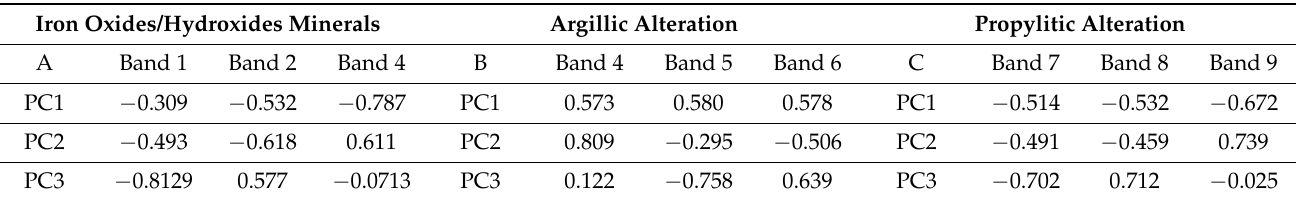
Table 2. Eigenvector statistics of the utilized